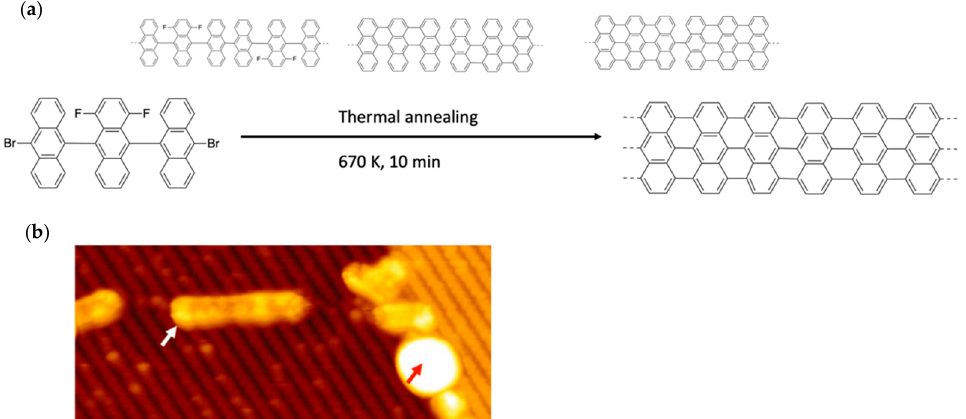
Figure 7. ( a ) Chemical pathway for the thermal-induced polymerization of 10,10 ″ -dibromo-1 ′ ,4 ′ - difluoro-9,9 ′ :10 ′ ,9 ″ -teranthracene (DBDFTA) into 7-armchair graphene nanoribbon on the rutile TiO 2 (011)-2x1 surface. ( b ) STM image (V s = 2.5 V, I t = 10 pA, 298 K, 13 × 6 nm 2 ) of 7-armchair graphene nanoribbon (highlighted with a white arrow) obtained after a thermal annealing of DBDFTA molecules. Thermal annealing leads also to the formation of side products, as shown with the red arrow.